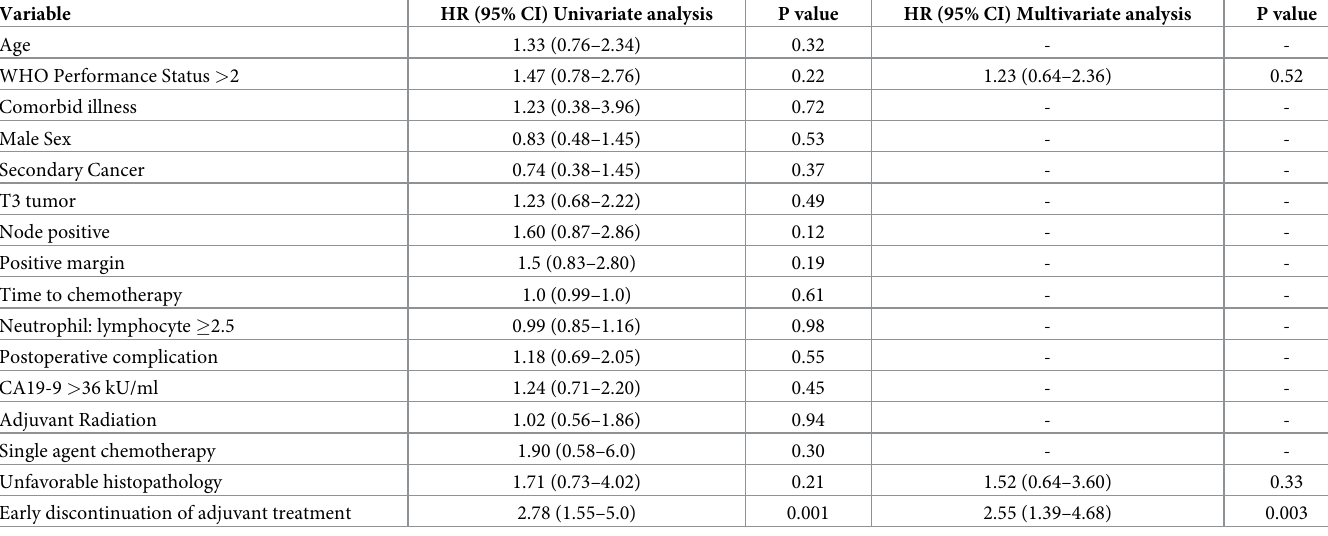
Table 5. Cox proportional analysis and modelling of various clinical and pathological variables that correlate with mortality (Overall survival).